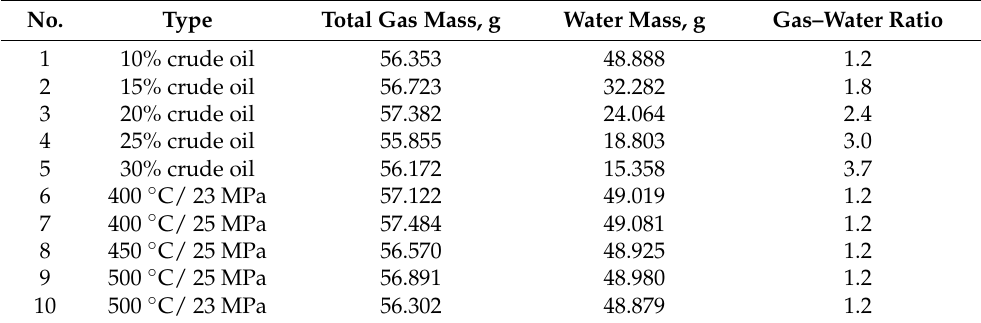
Table 14. Gas–water mass ratio of supercritical multi-thermal fluid generated by supercritical water crude oil reaction under different conditions.